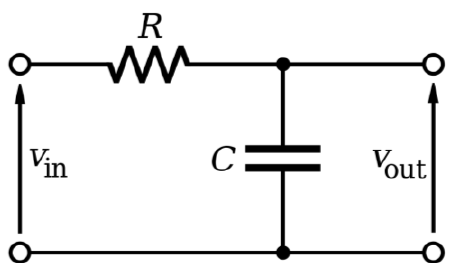
Figure 2. Scheme of a LP filter. R is the resistor and C is the capacitor. According to Kirchhoff’s Laws and the definition of capacitance: